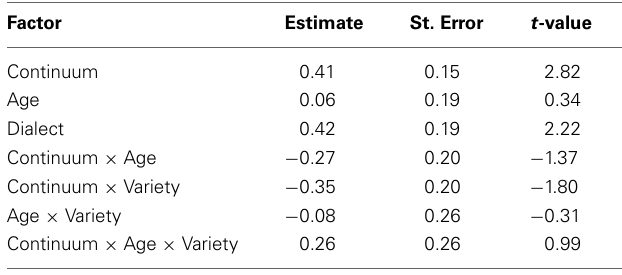
Table 3 | Estimates, Standard error, and t-statistics for the independent factors in the mixed model with slope as the dependent variable.